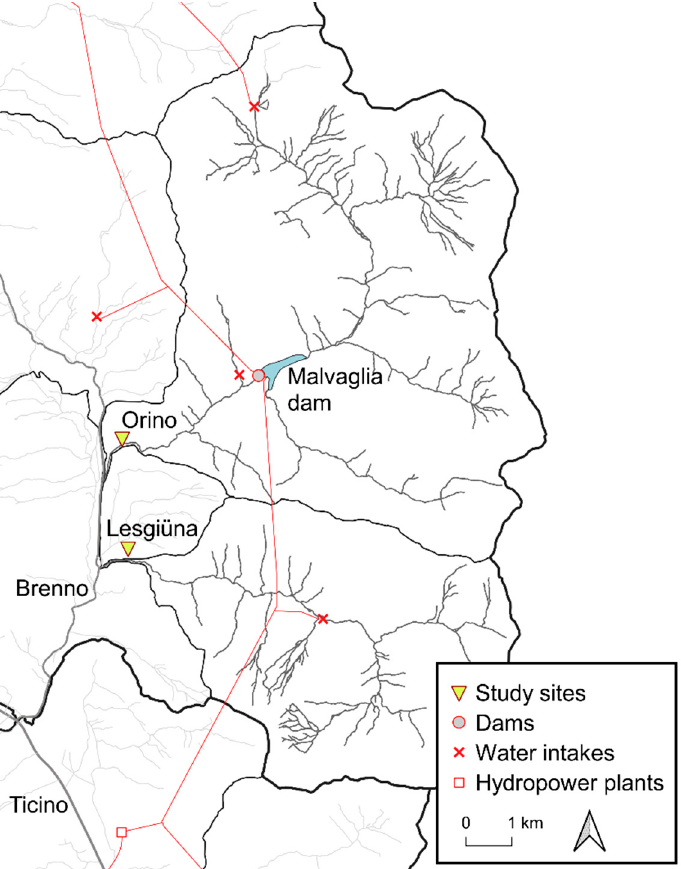
Figure 1. Overview of the study streams, catchments, and the hydropower network. Source of data: Swiss Federal Office of Topography.